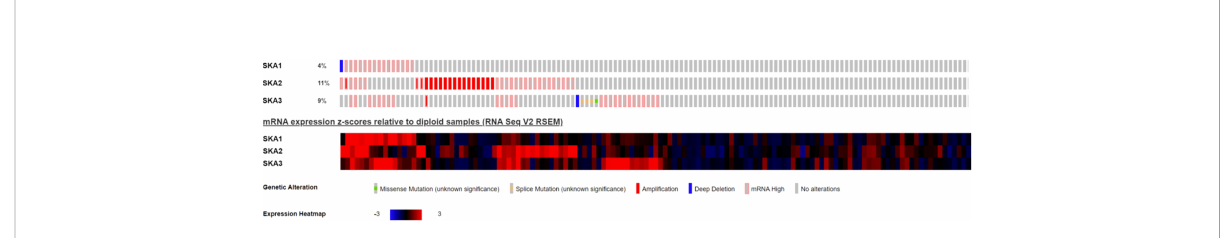
FIGURE 3 Expression of SKA1/2/3 in cBioPortal database in HCC patients; SKA, spindle and kinetochore-associated; HCC, Hepatocellular